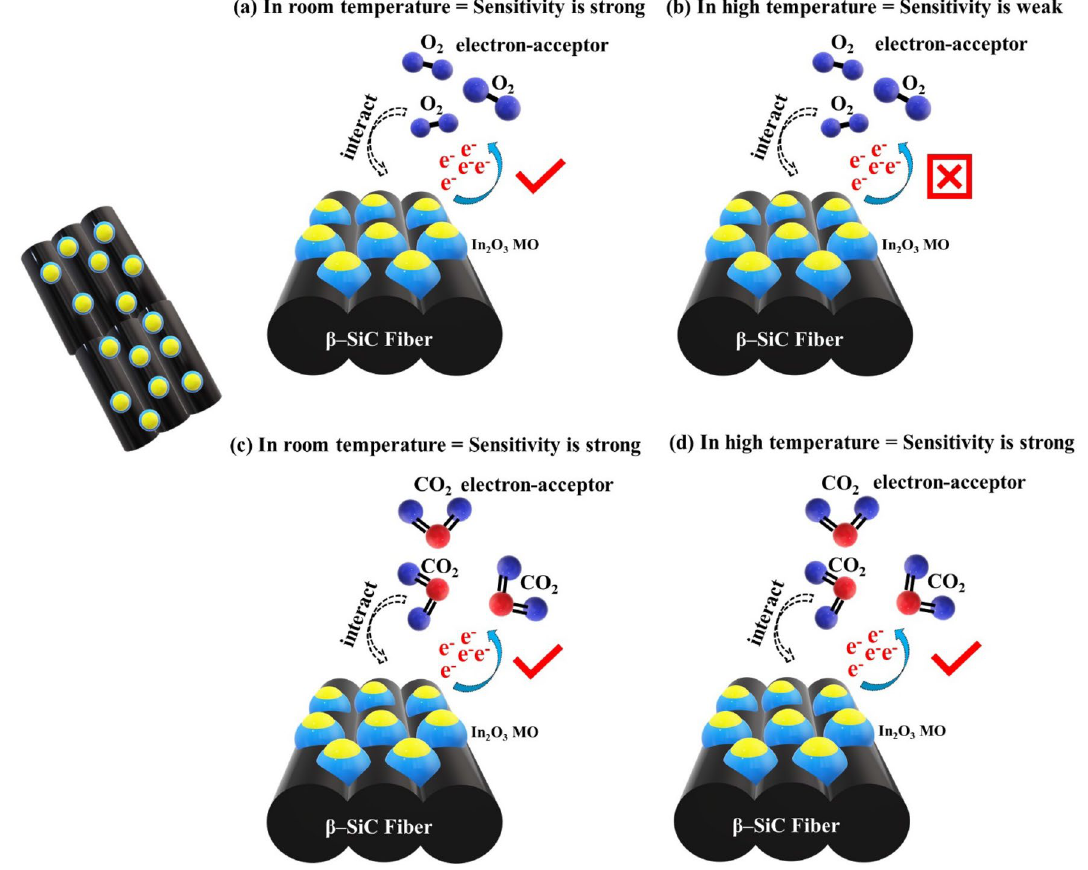
Figure 13. Schematic illustration of the CO 2 and O 2 gas sensing performance on the β-SiC-In 2 O 3 sensor at ( a , c ) room temperature (25 °C) and ( b , d ) high temperature (350